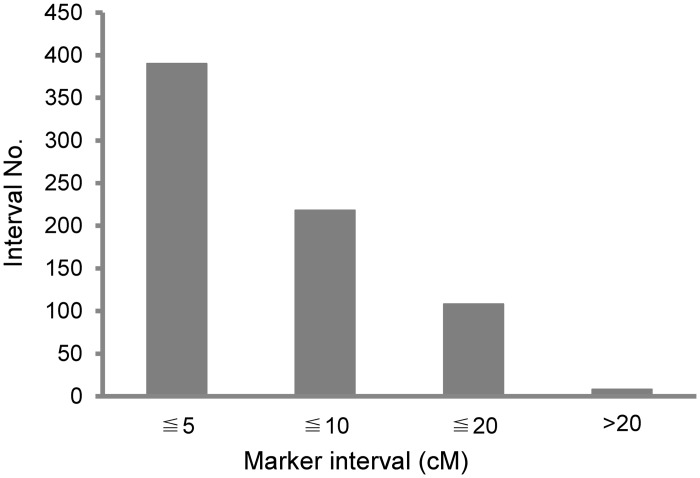
Overview of genetic distance between two adjacent markers on the linkage groups.